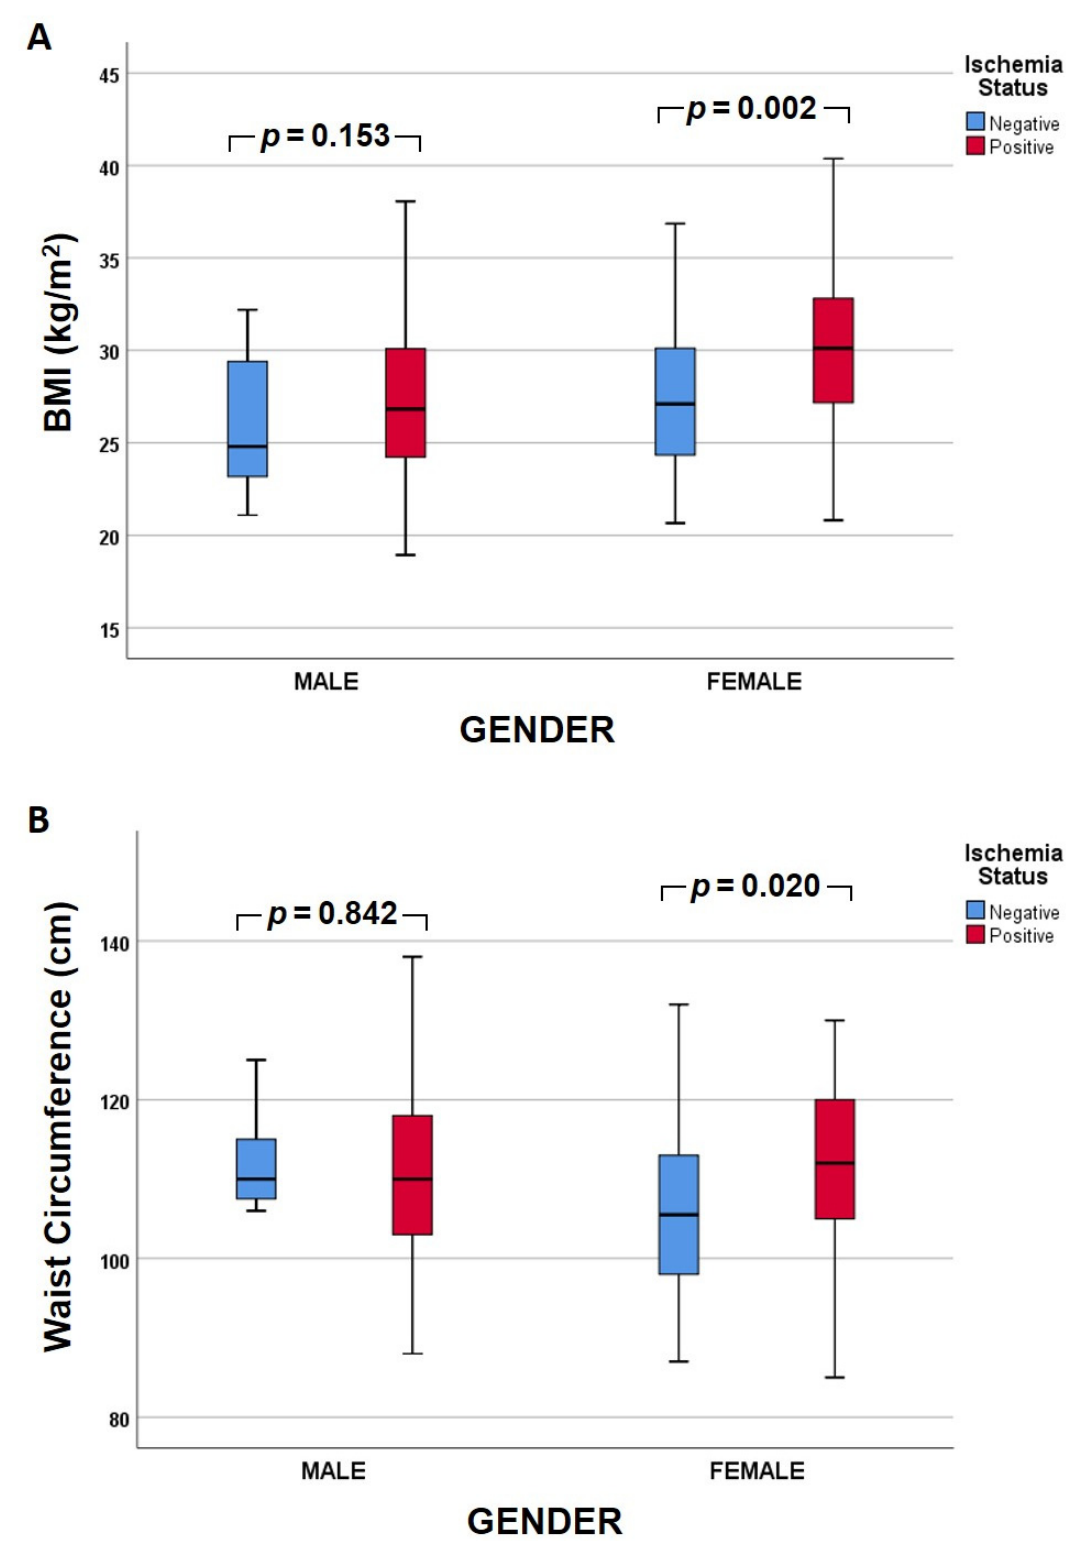
Figure 2. Clustered box plot of ( A ) body mass index (BMI)and ( B ) waist circumference between the ischemia and non-ischemia groups according to sex (primary grouping). Each box plot shows the median (bold line), the 25th and 75th quartile (lower and upper box border, respectively), and the minimum and maximum values (whiskers).